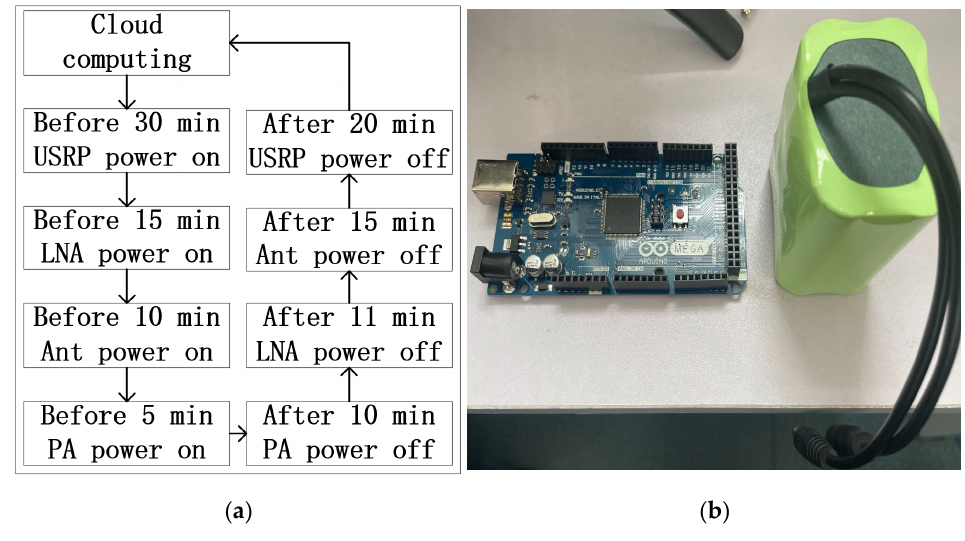
Figure 17. ( a ) Power control flow; ( b ) power control devices.